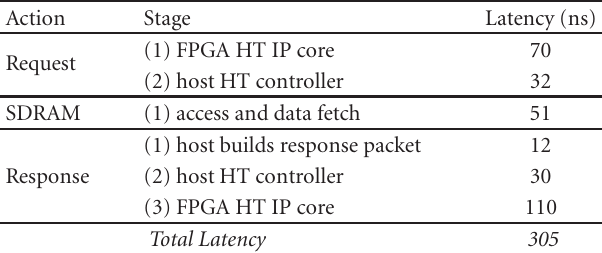
Table 3: A breakdown of how each stage of an HT memory request contributes to overall access